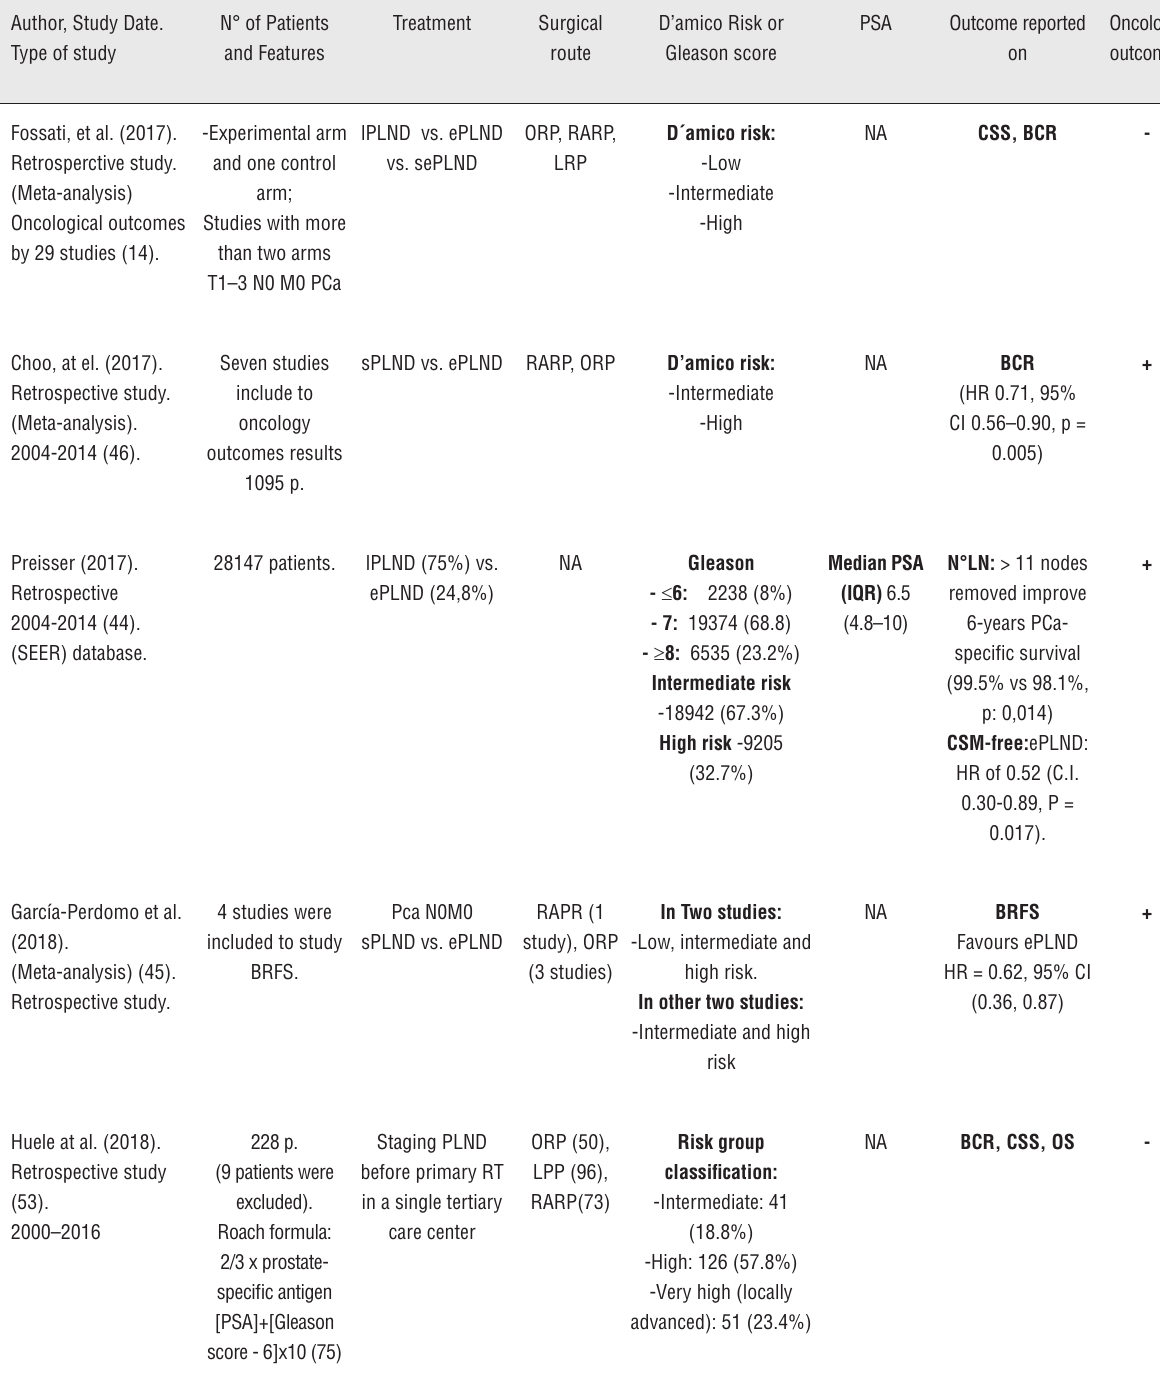
Table 1 - Baseline characteristics for studies addressing: Author and Study Date, type of study, numbers of patients and Features, surgical route, D’amico Risk or Gleason score, PSA and reports on oncologic outcomes.